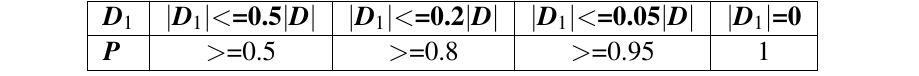
Fig. 7 Diagram of two-point Radiation Source